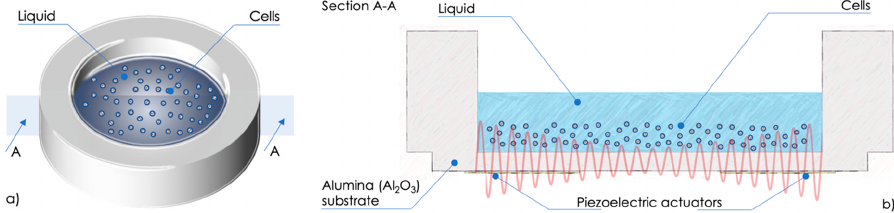
Figure 1. Sketch ( a ) and cross-section A-A ( b ) of the device developed to steer and confine cells dispersed in liquid.